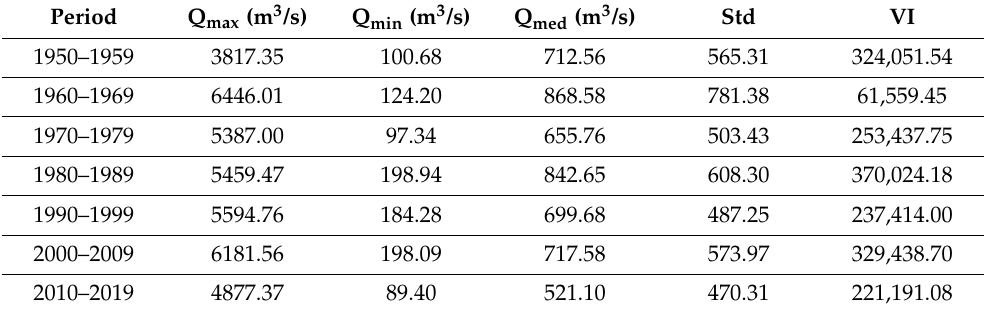
Table 3. Fluvial discharge in the Para í ba do Sul River (1950–2019). Qmax: maximum discharge. Qmin: minimum discharge. Qmed: average discharge. Std: standard deviation. VI: variance index